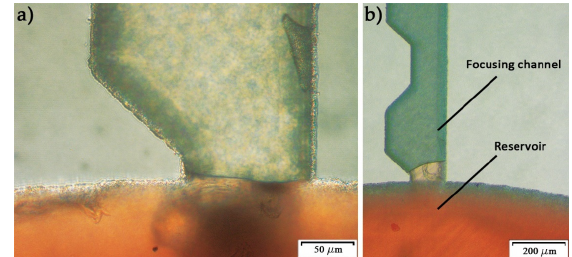
Figure 3. Dyed deionized (DI) water flow experiment inside the focusing channel. Picture ( a ) shows the fluid stopping at the channel inlet due to the pressure barrier caused by the width expansion, while picture ( b ) is taken after rotating the microfluidic disc at 1500 rpm.